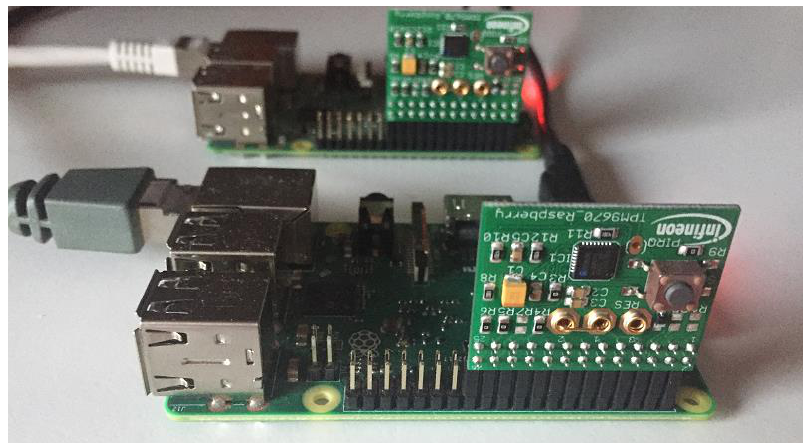
Figure 3. Experimental setup with two Raspberry Pi boards and two Infineon TPM2.0